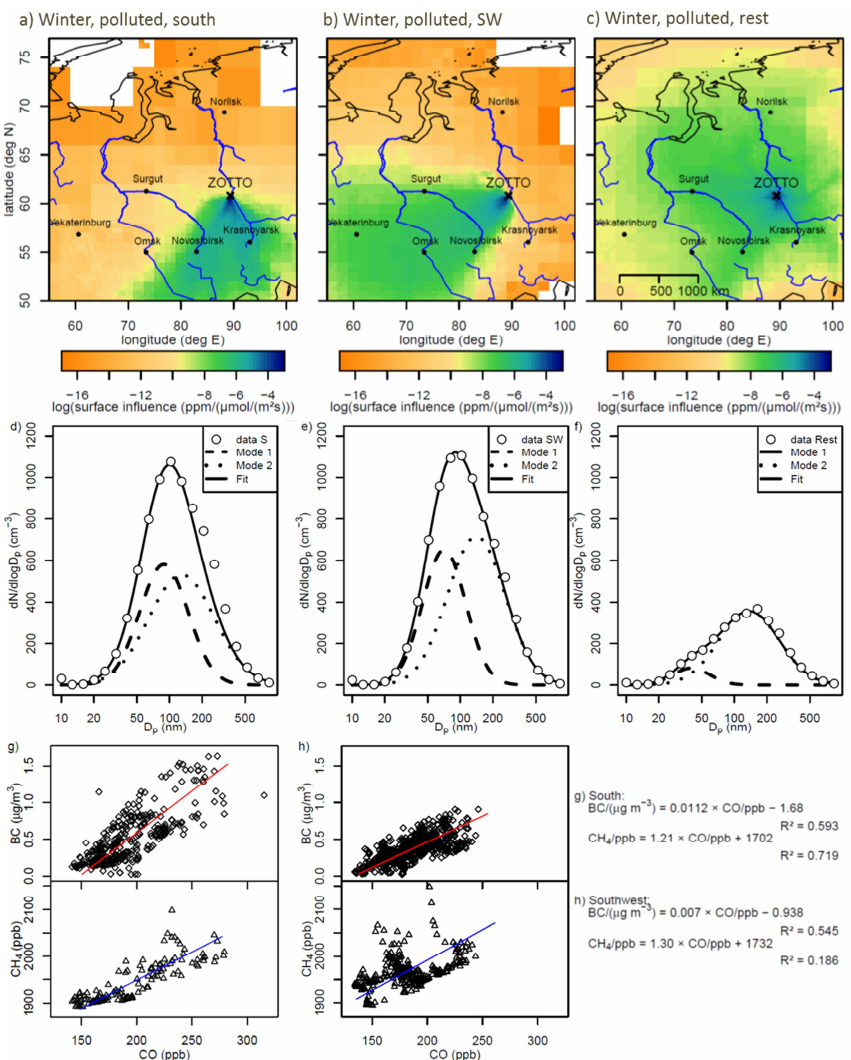
Figure 5: Footprints for winter polluted south region (a), winter polluted southwestern region (b), and winter polluted rest region (c); aerosol size distribution for south (d), southwestern (e), and rest regions (g); BC e and CO , CH 4 and Fig. 5. Footprints for winter polluted south region (a) , winter polluted southwestern region (b) , and winter polluted rest region (c) ; aerosol CO scatter plots for south (g), and southwestern regions (h). size distribution for south (d) , southwestern (e) , and rest regions (f) ; BC e and CO , CH 4 and CO scatter plots for south (g) , and southwestern regions (h)